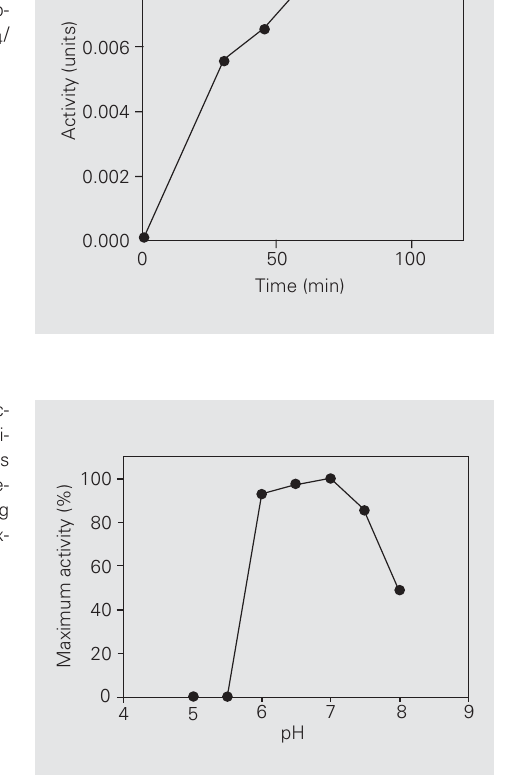
assay.Figure 3. (cid:0) (cid:1) -L-fucosidase activity as a function of incubation time. An epimastigote extract (0.4 mg) was incubated with p -nitro- phenyl- (cid:1) -L-fucopyranoside for the times indicated on the ab- scissa in 66 mM NaH 2 PO 4 / Na 2 HPO 4 buffer, pH 7.0.